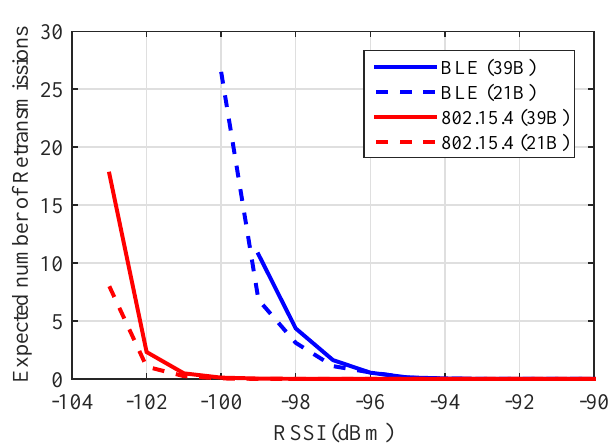
Figure 3. Estimated number of retransmissions required for the successful transmission of a single frame.